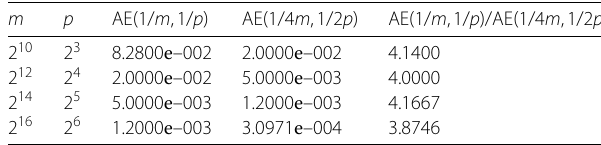
Table 3 Errors of (32) with θ = 0